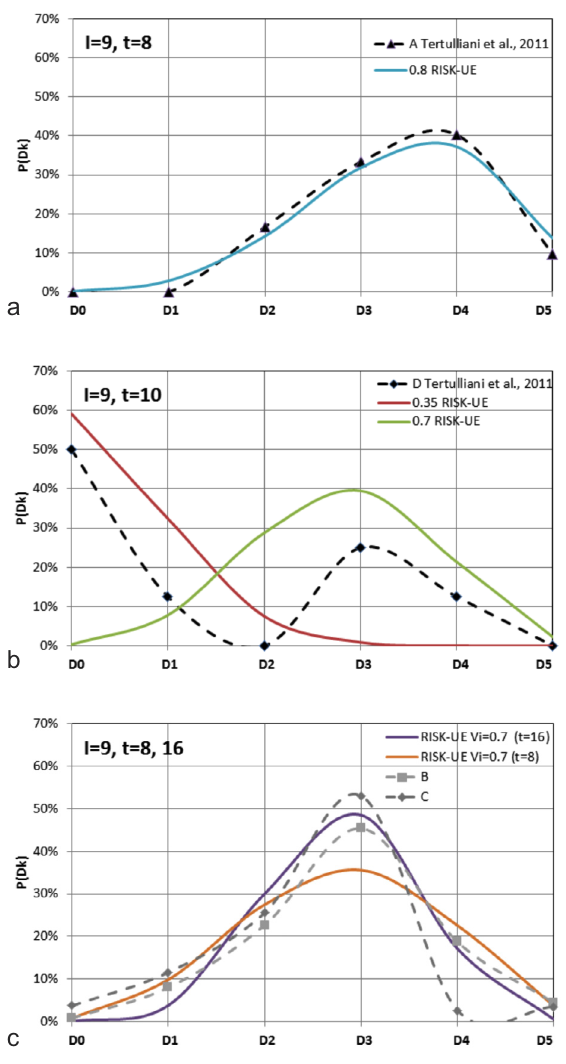
Figure 11. Calibration of the vulnerability indexes and of the “t” parameter for EMS98 vulnerability classes (class A –a, class D- b and classes B and C –c) based on data from Tertulliani et al.